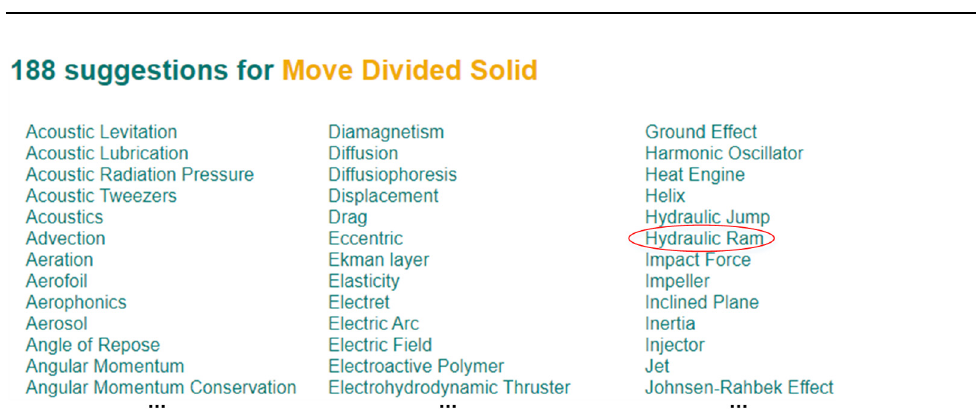
( b ) Figure 23. ( a ) Interaction matrix of system components, products, and super-system components for the preliminary solution; ( b ) Function model of the preliminary solution. •